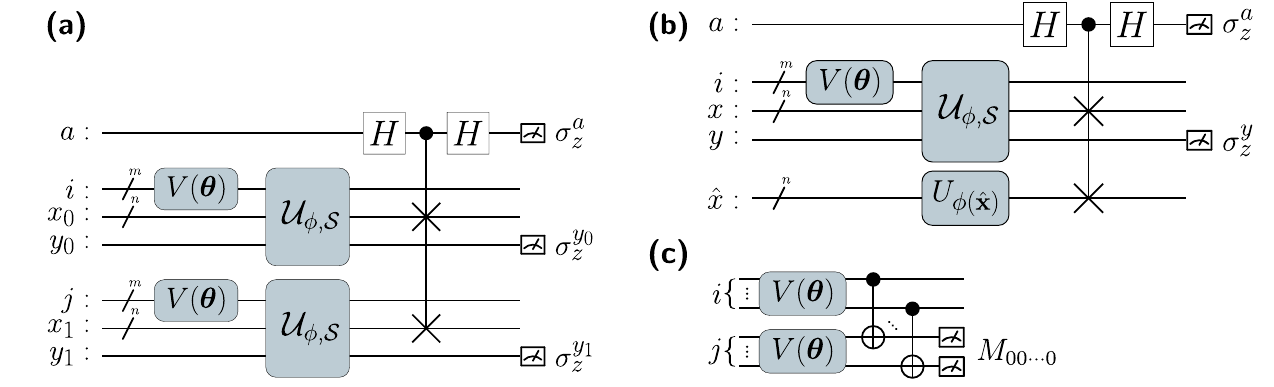
)/ √ 2 , and the rest to ( 0 1 |+� = | � + | � x ) x to a quantum state φ( . n denotes the | ˆ � ˆ